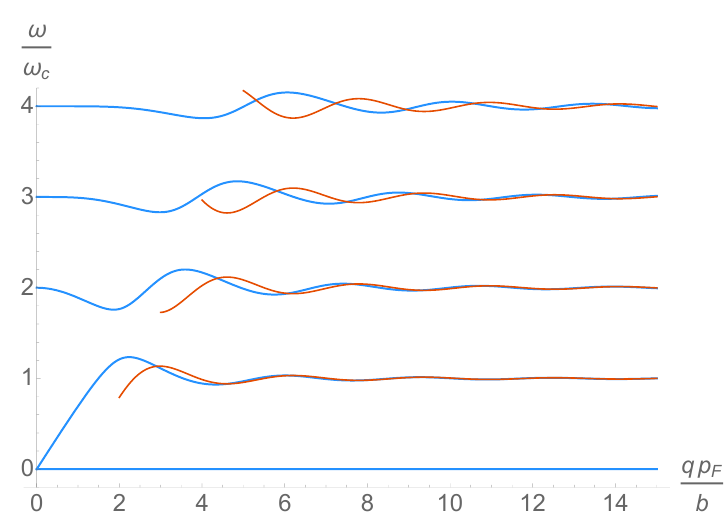
Figure 1 . Spectrum of excitations for the anyon